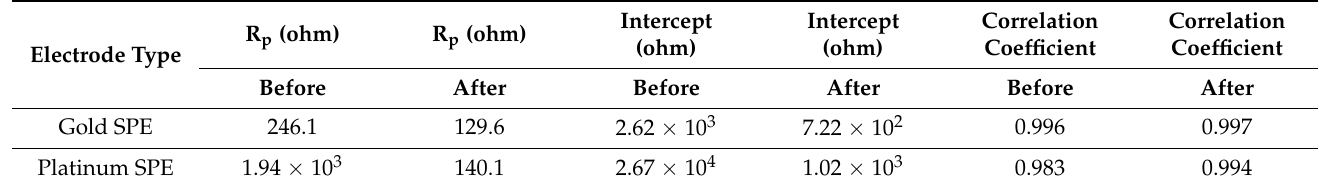
Table 5. Faradaic current peak I m and faradaic potential V f , before cleaning versus faradaic current peak I m and faradaic potential V f after cleaning with hydrogen peroxide .